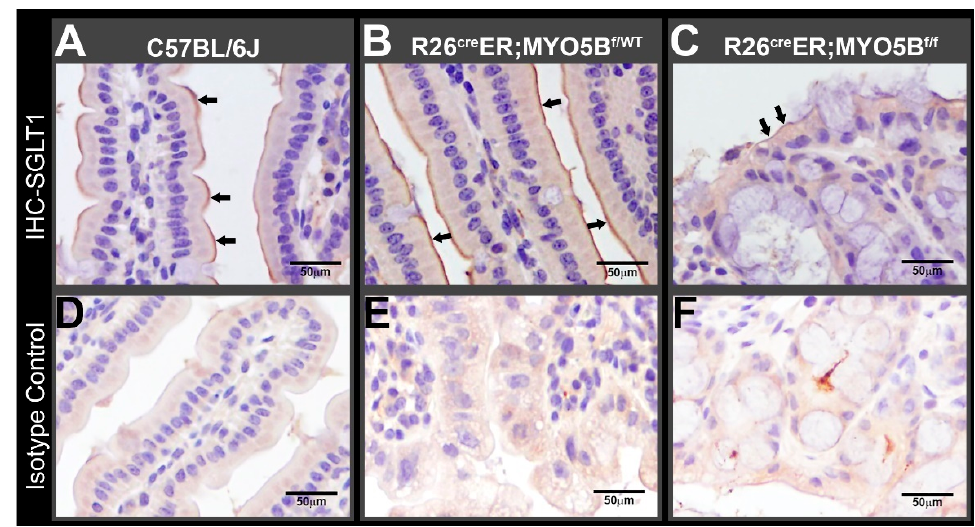
Figure 4. SGLT1 immunolabel is reduced in villus enterocytes from R26 cre ER;MYO5B f/f (Homozygous) mouse jejunum. Horseradish peroxidase staining detects SGLT1 (arrows) in jejunal villus sections from paraffin-embedded blocks of ( A ) C57BL/6J (WT), ( B ) R26 Cre ER;MYO5B f/wt (Heterozygous), and ( C ) R26 Cre ER;MYO5B f/f (Homozygous) mouse intestine. ( D – F ) are isotype controls for negative staining of ( A – C ), respectively. Arrows indicate SGLT1 labeling. Nuclei are stained blue. Scale bars: 50 µm.